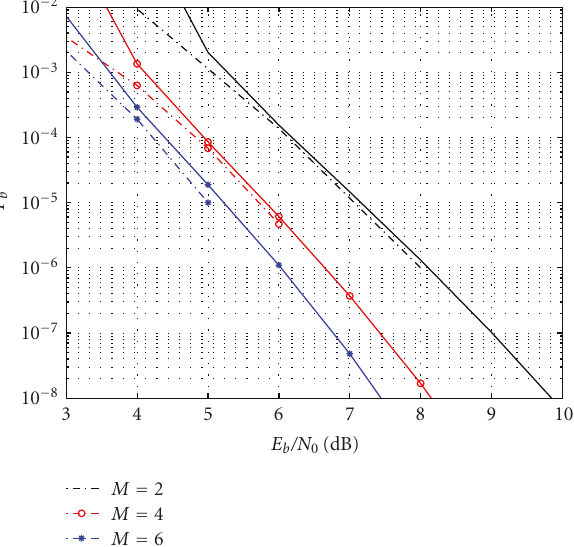
Figure 7: Bit-error probability of 8PSK TCM-coded SC with di ff erent number of diversity branches in Nakagami fading wih m = 4 (solid: bound, dashed: